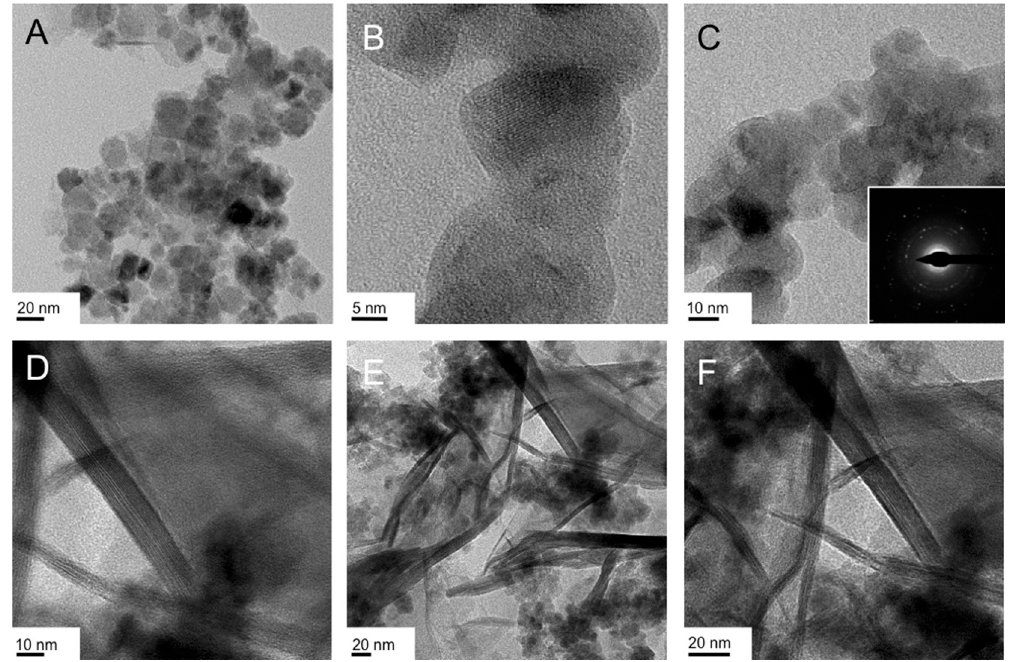
Figure 7. TEM images of the IO nanostructures obtained from the reduction/hydrolysis synthesis of FeCl 3 in the Col hI phase formed by CTAB (25 wt %) in water at 25 °C: ( A – C ) froth fraction and ( D – F ) gel fraction. The inset in ( C ) shows the selected area electron diffraction (SAED) pattern, which confirms the crystallinity of these quasi-circular nanodiscs.